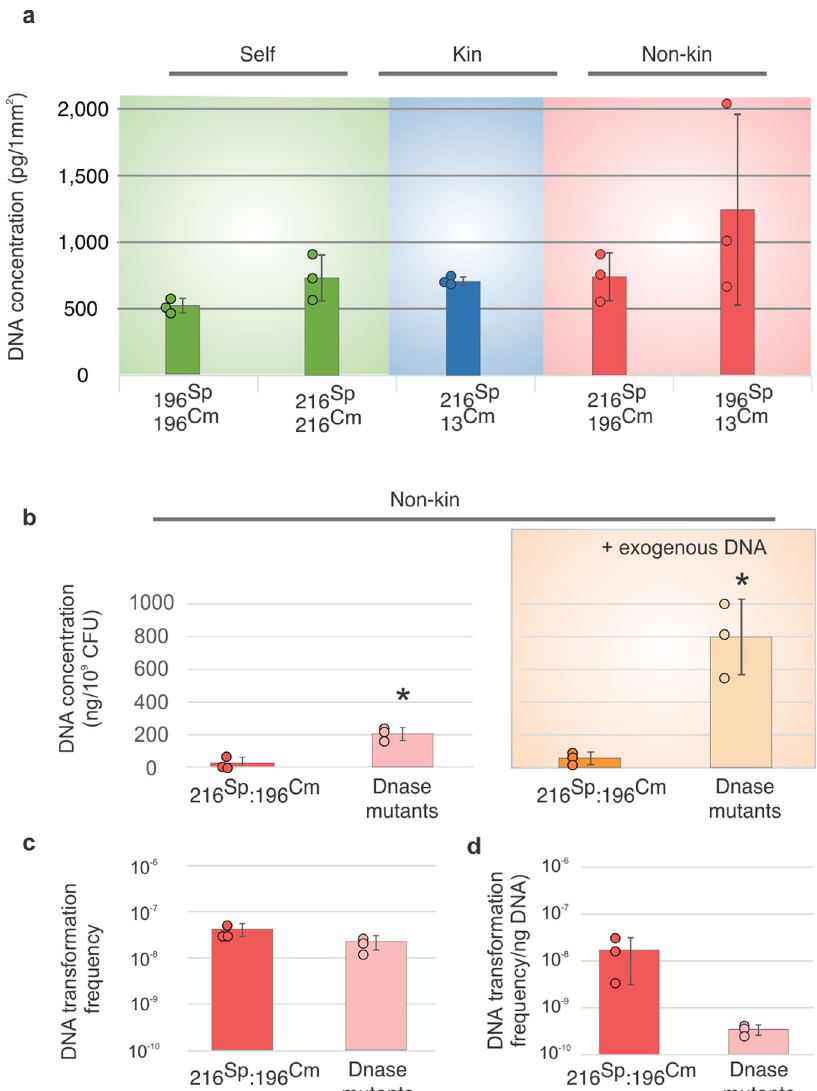
Fig. 4 Transformation frequency at swarm boundaries is largely unaffected by DNA concentration. a DNA concentrations at the meeting points of self- controls (green), kin (blue) and non-kin strains (red), b DNA concentration at the swarm boundary between non-kin wt PS-216 Sp and PS-196 Cm (red) and between nuclease mutants (DNase mutants) PS-216 Sp Δ yhcR Δ nucB and PS-196 Cm Δ yhcR without exogenously added DNA (pink) (left panel) and with 30 µ g DNA added at the swarm boundary (right panel, wt orange, DNase mutants yellow), asterisks represent statistically signi fi cant values compared to corresponding wt pairings (two tailed Student ’ s t- test for unpaired data assuming equal variances), c transformation frequency at the boundary of two non- kin wt (PS-216 Sp and PS-196 Cm ) (red) and between two nuclease mutant strains (PS-216 Sp Δ yhcR Δ nucB and PS-196 Cm Δ yhcR ) (pink), d transformation frequency at the boundary of two non-kin wt strains (PS-216 Sp and PS-196 m ) (red) and between two nuclease mutants strains (PS-216 Sp Δ yhcR Δ nucB and PS-196 Cm Δ yhcR ) (pink) calculated per ng available DNA. Assays were replicated three times. See Table 2 for strain abbreviations. Data are presented as mean values ±SD and error bars represent SD of the mean values ( n = 3). For statistical parameters see Supplementary